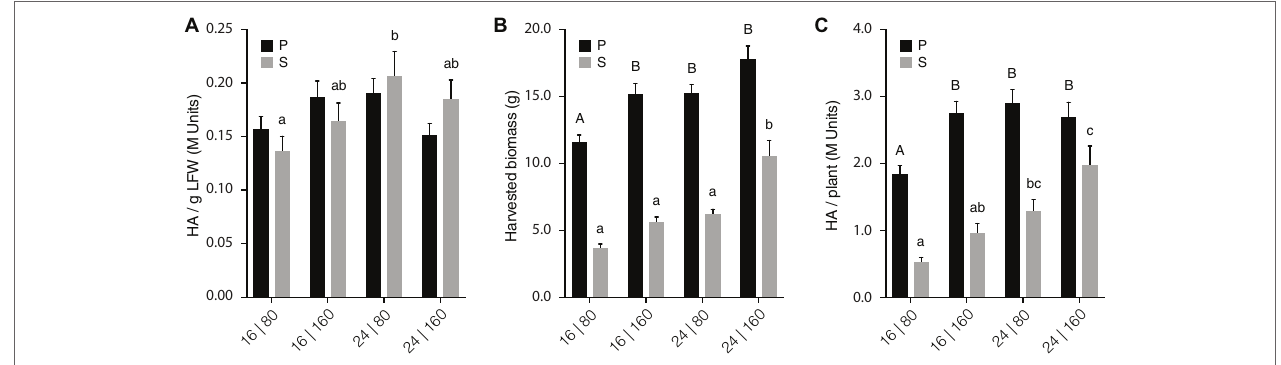
FIGURE 3 | PPFD and light photoperiod influence total H1 yield via their strong impact on axillary growth. H1 hemagglutination activity (A) , leaf biomass following H1 expression, (B) and total H1 yield (C) for each leaf production unit are given for the four PPFD/photoperiod treatments. Each bar is the mean of 14 independent (replication) values ± se . On each panel, bars with different letters (uppercase letters for P units, lowercase letters for S units) indicate statistically significant differences between treatments (post-ANOVA Tukey’s test; p < 0.05). P, leaf production units P1–P3; S, leaf production units